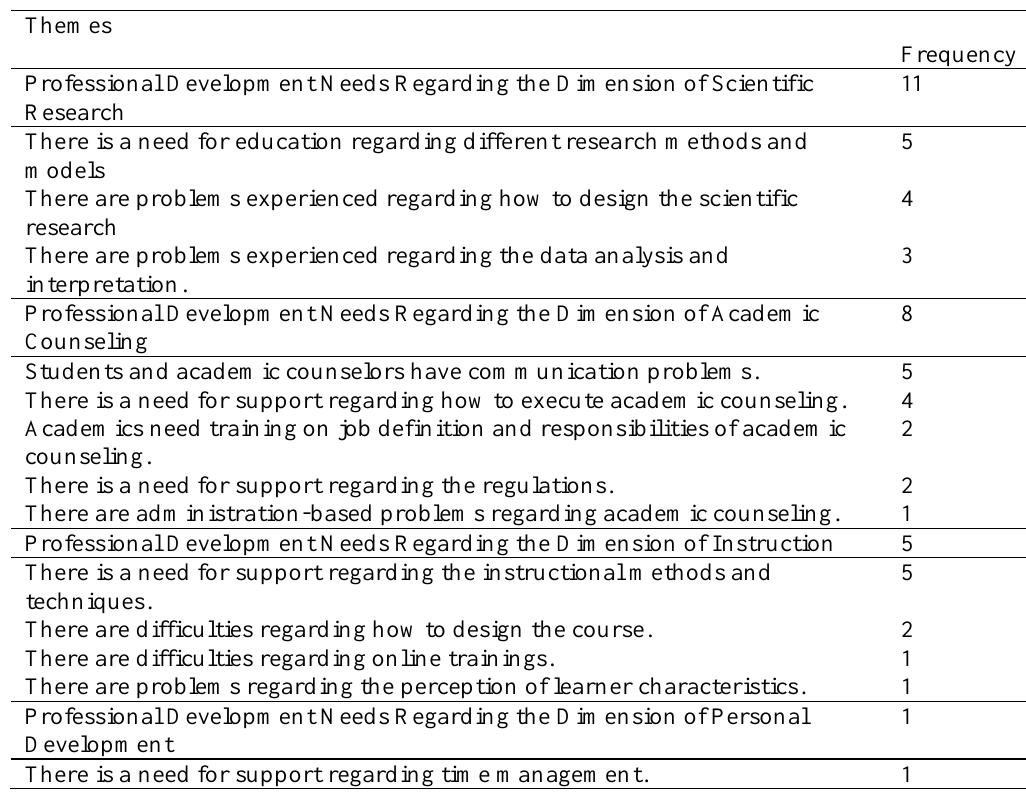
Table 2 Professional Development Needs of the